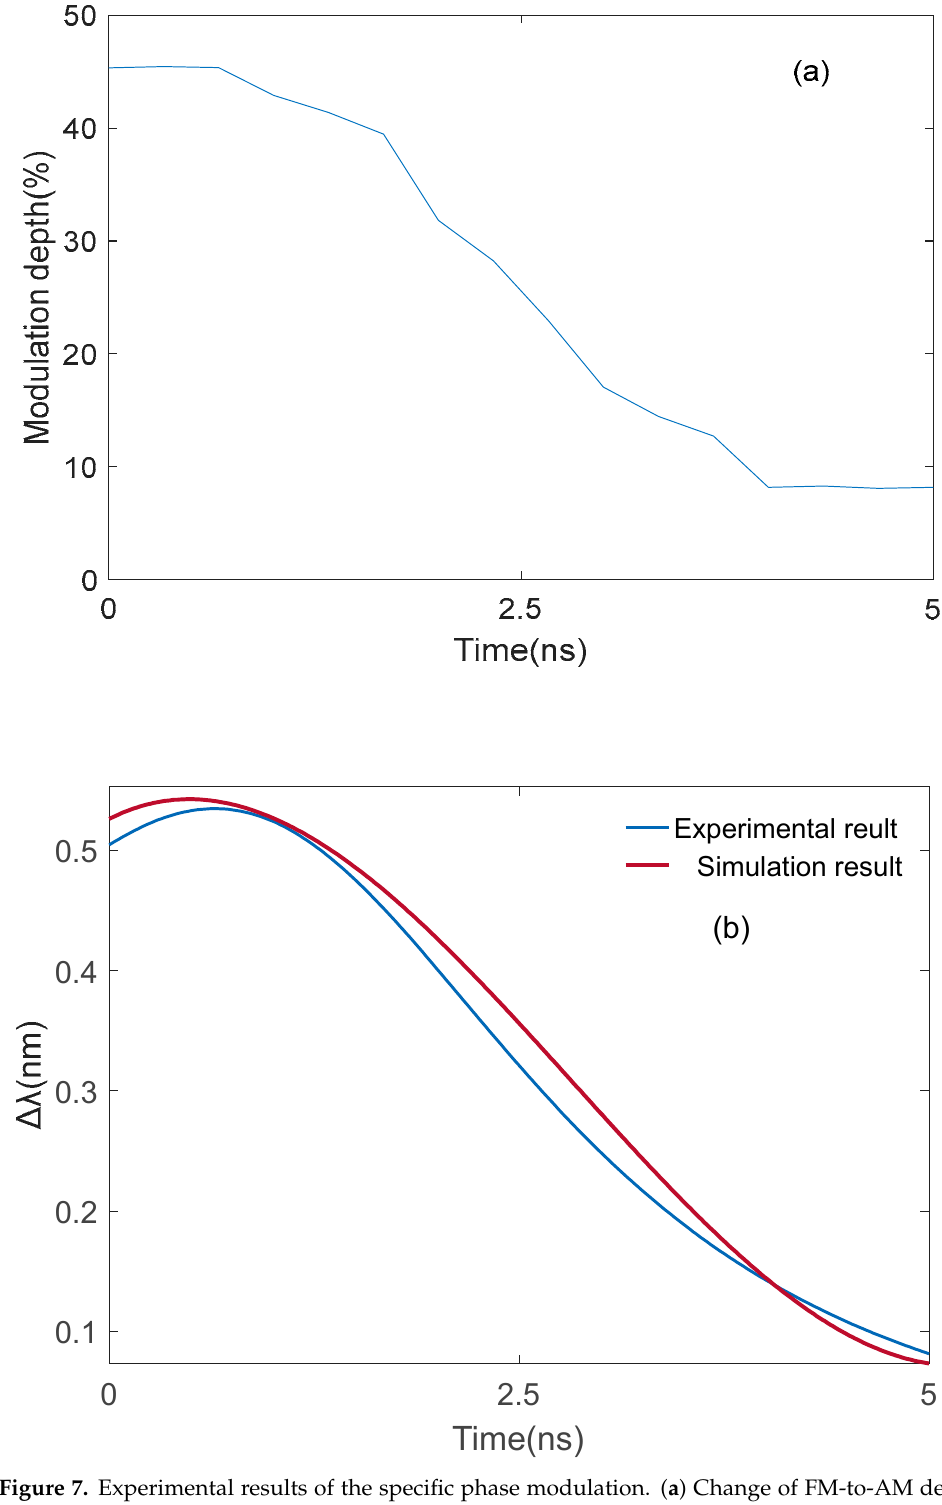
Figure 7. Experimental results of the specific phase modulation. ( a ) Change of FM-to-AM depth. ( b ) Change of spectral width with time.